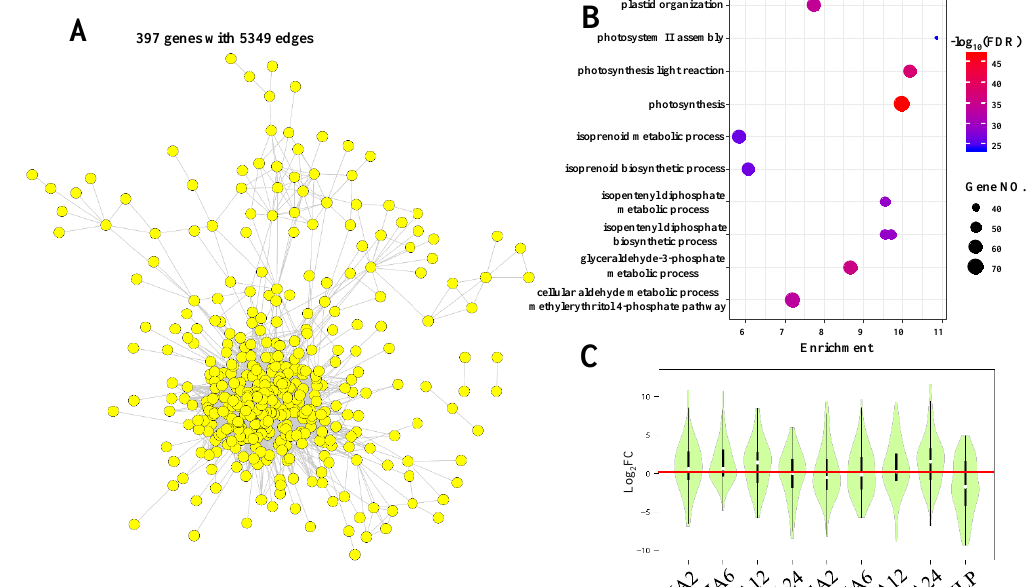
Figure 8. Gene co-expression networks of co-expression module four ( A ). The nodes and edges represented the genes and the significant correlations between genes, respectively. Genes without any edges were not presented in the network. The top 10 significantly enriched GO terms in biological processes in CM4 ( B ). The average expression levels of CRG from CM4 upon different treatments ( C